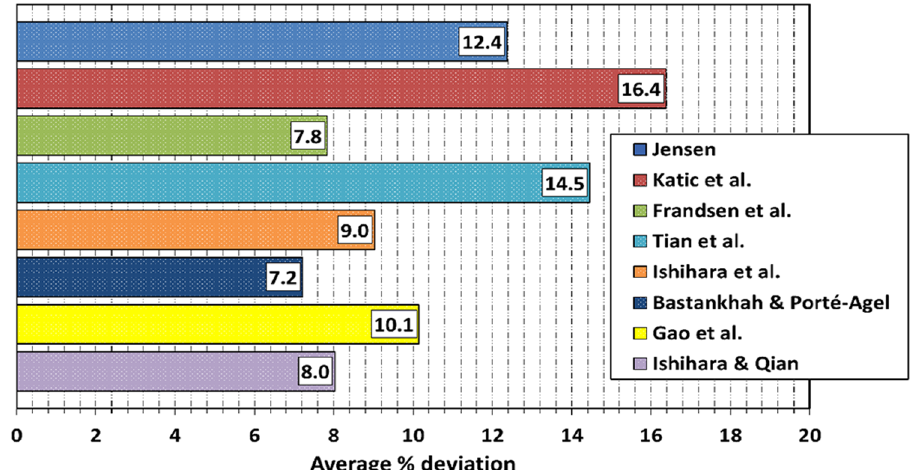
Fig. 6. Average percentage deviation of each wake model in the entire far-wake region for upstream wind speed value equal to 5 m/s.